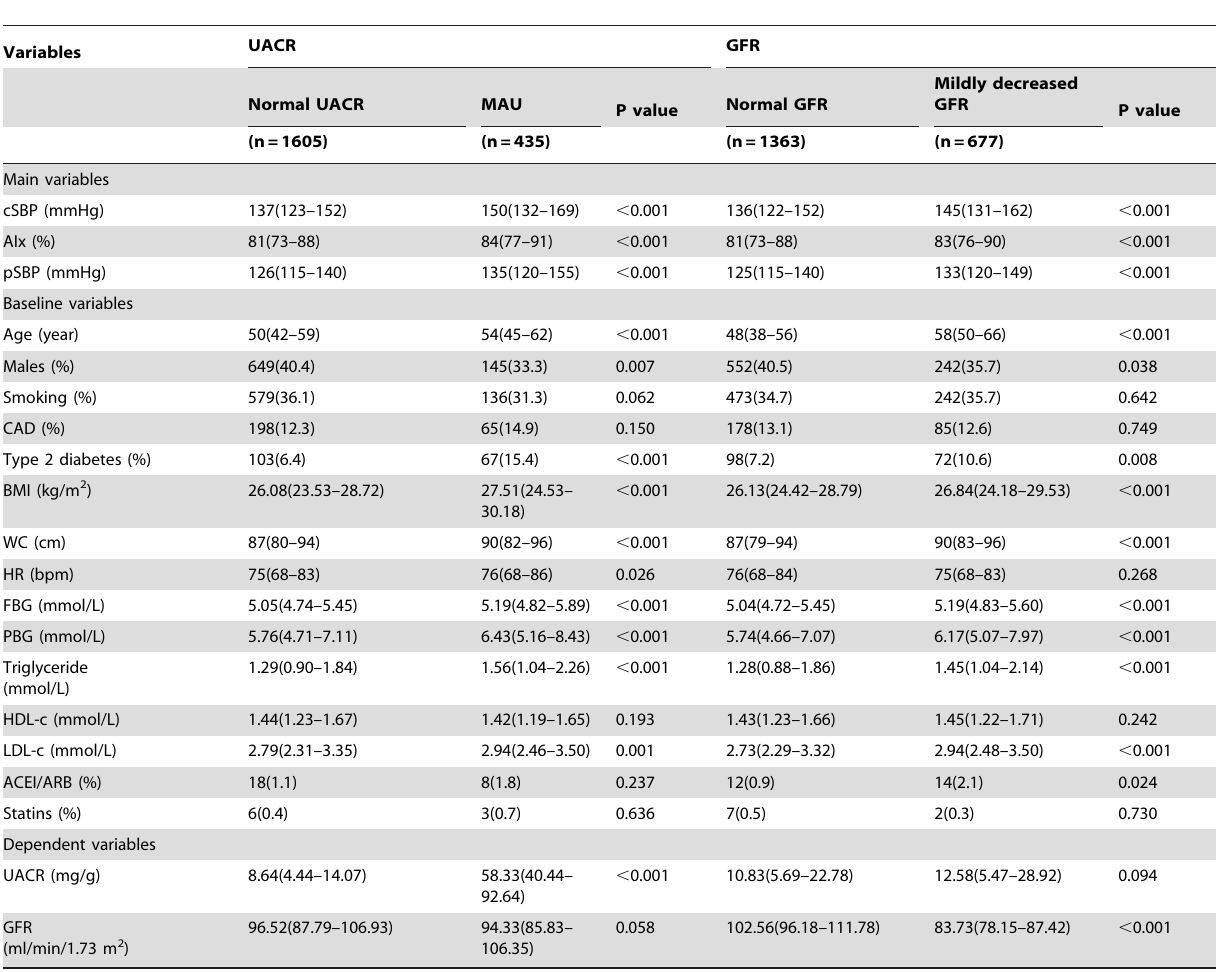
Table 1. Characteristics of study population grouped in patients with and without MAU or mildly decreased